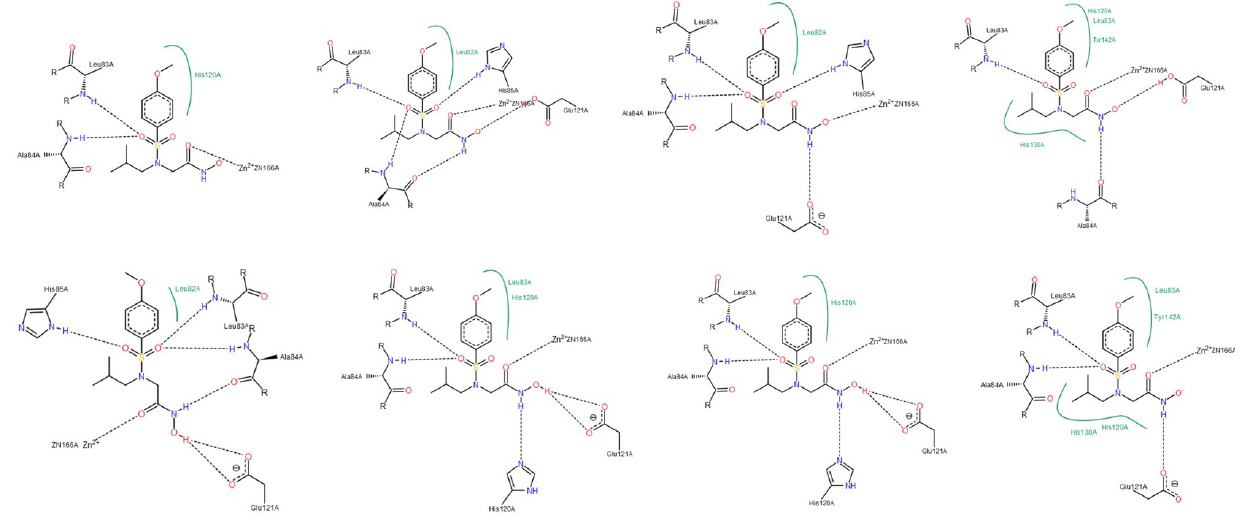
Figure A2. Interactions between NNGH inhibitor and MMP-2, by PoseView calculations.